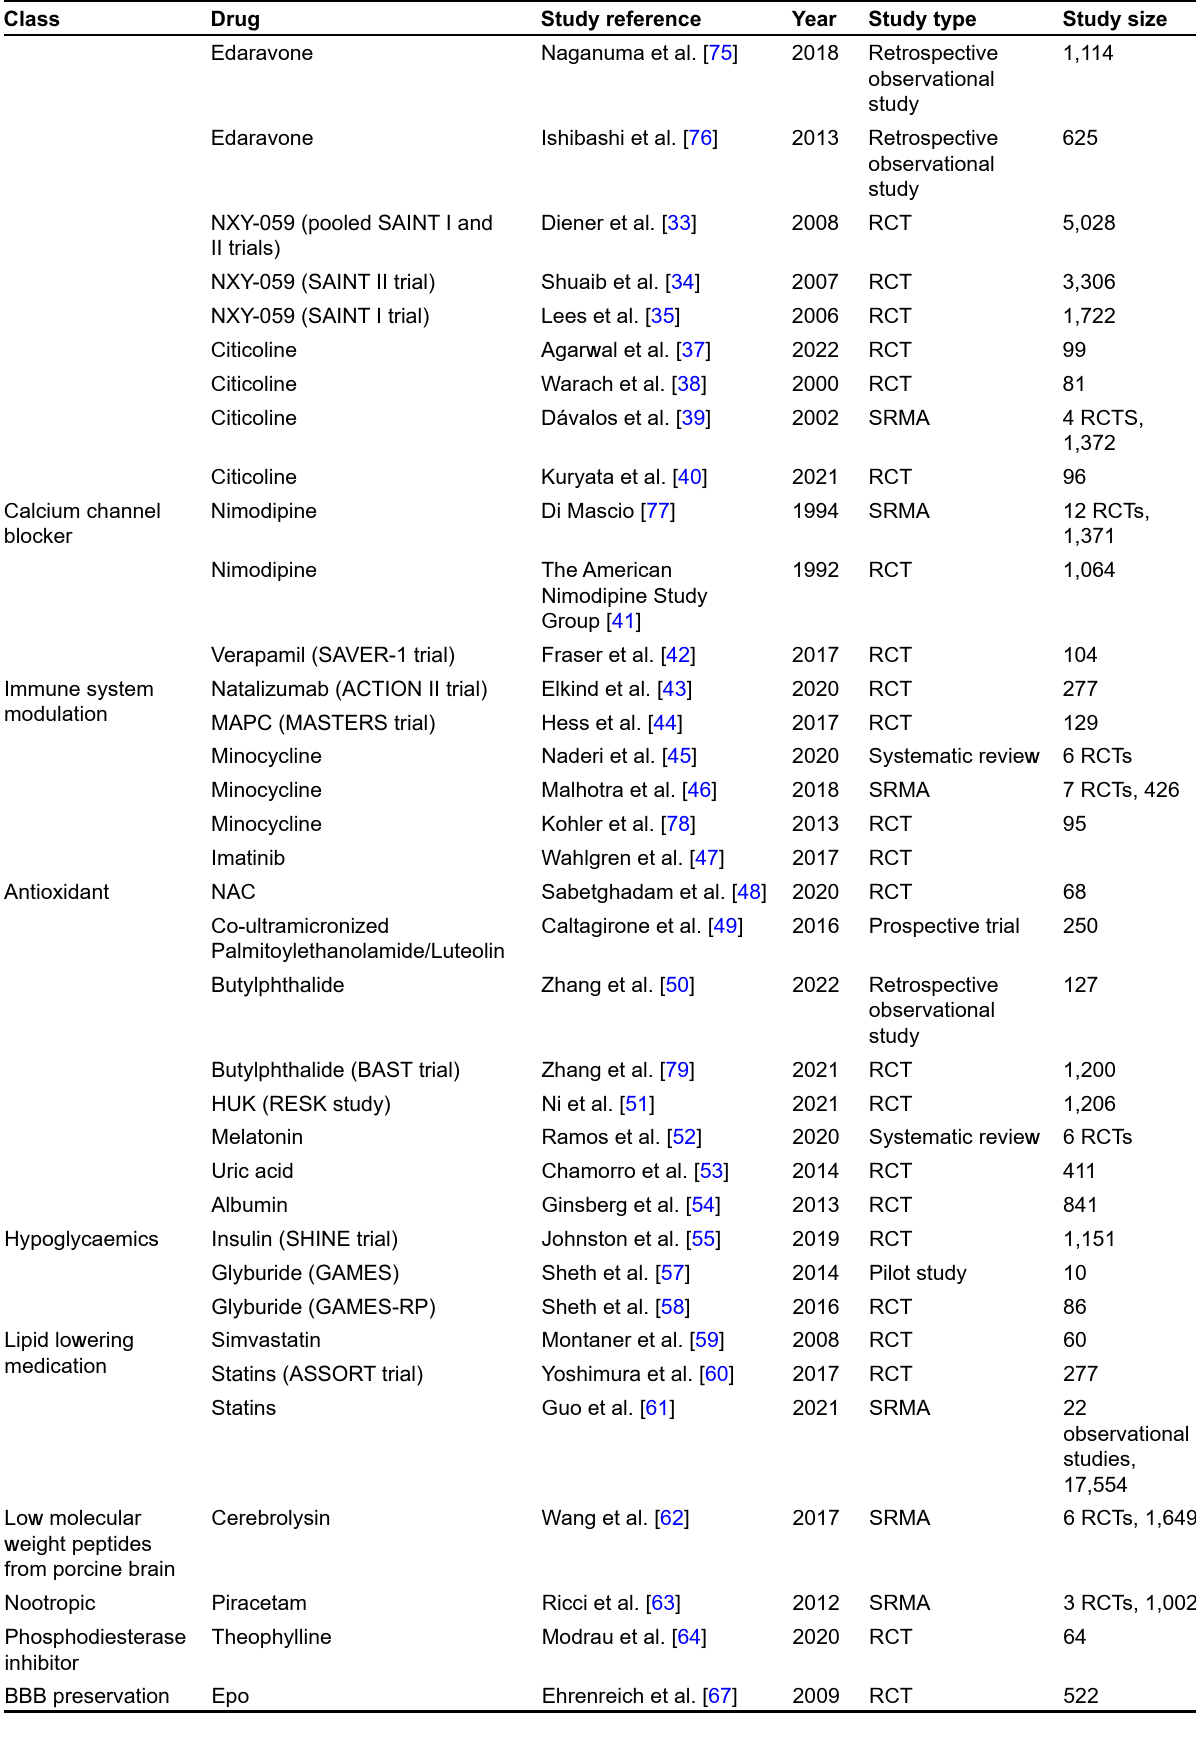
Table 2. Characteristics of human trials on neuroprotective agents in AIS ( continued )